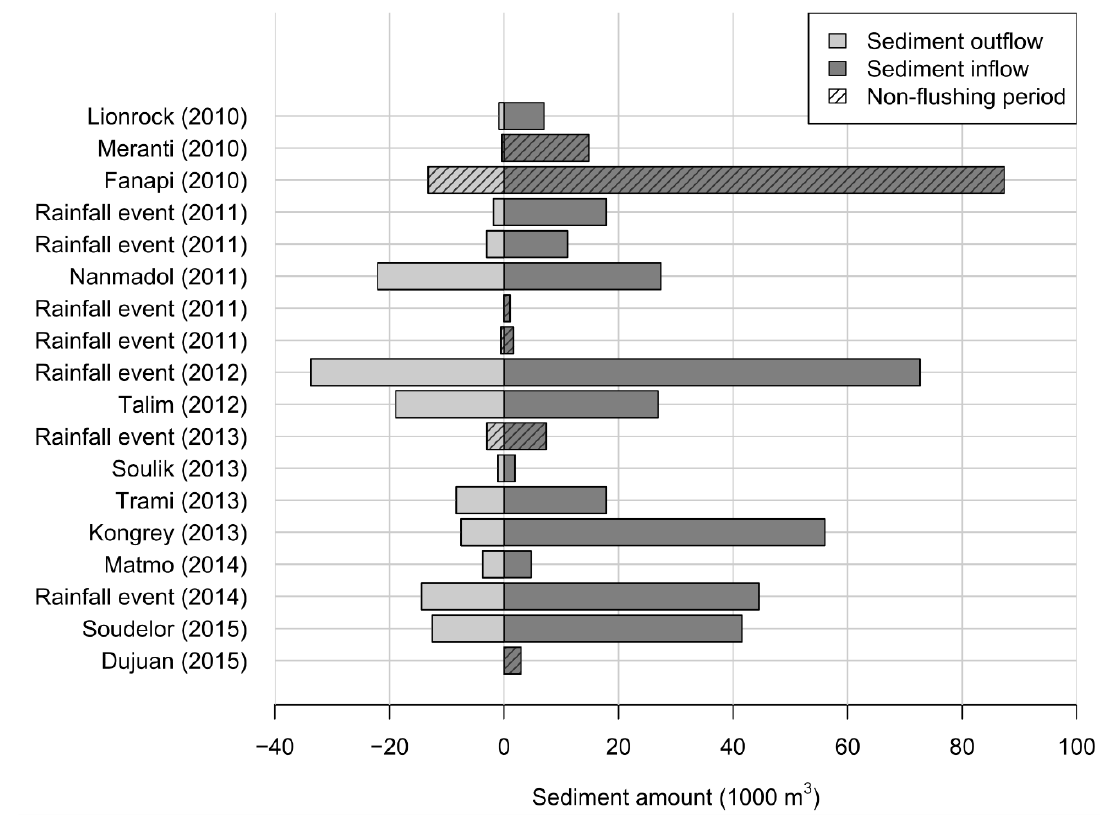
Figure 4. Amounts of the sediment inflow and outflow for the 18 observed rain events. Data provided by Taiwan’s Water Resources Agency.